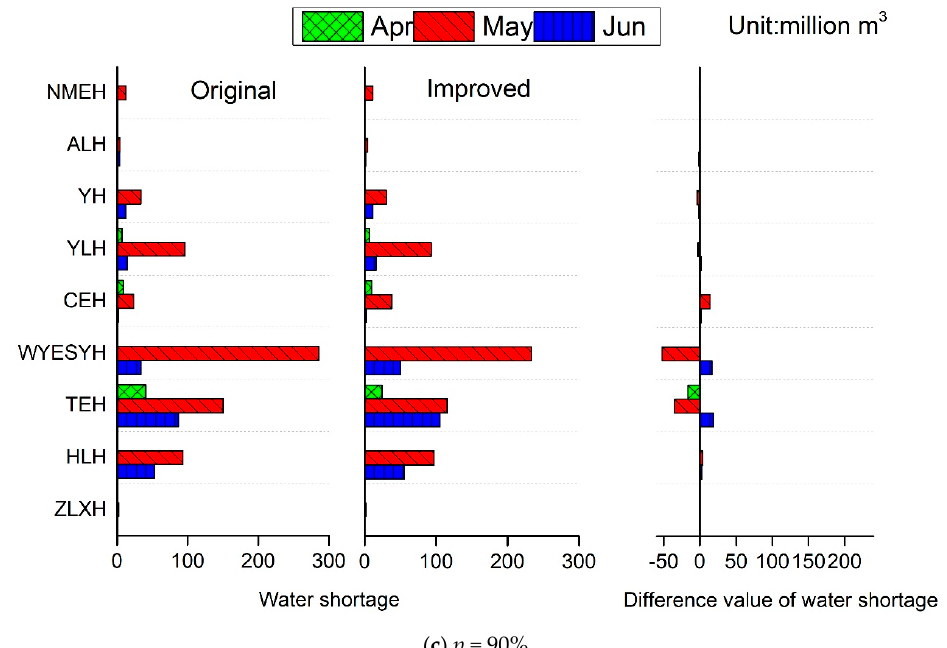
Figure 5. The difference in water shortage quantity before and after improvement under different precipitation frequencies.